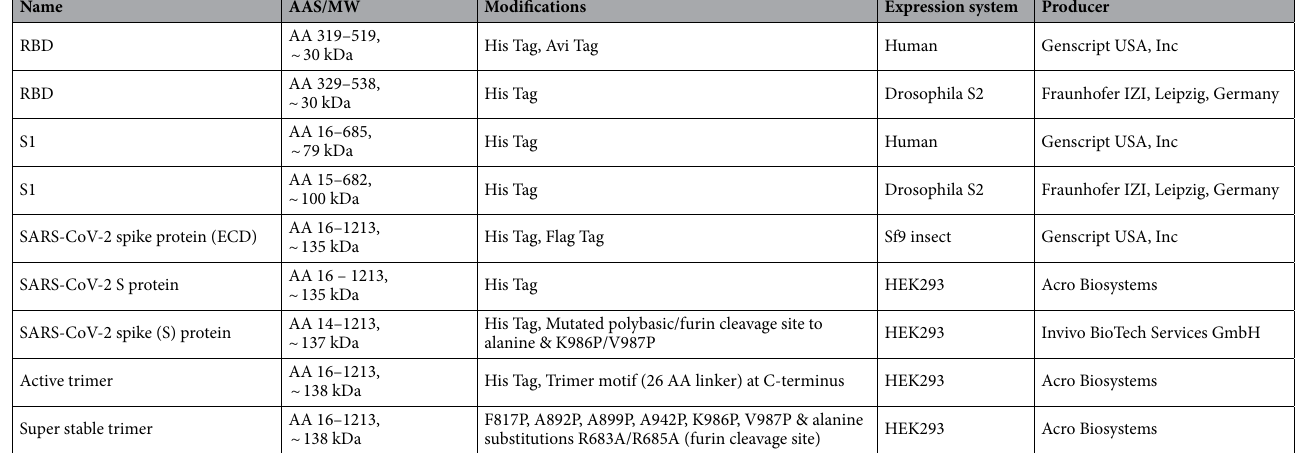
Table 1. Spike protein fragments and full-length spike proteins and their